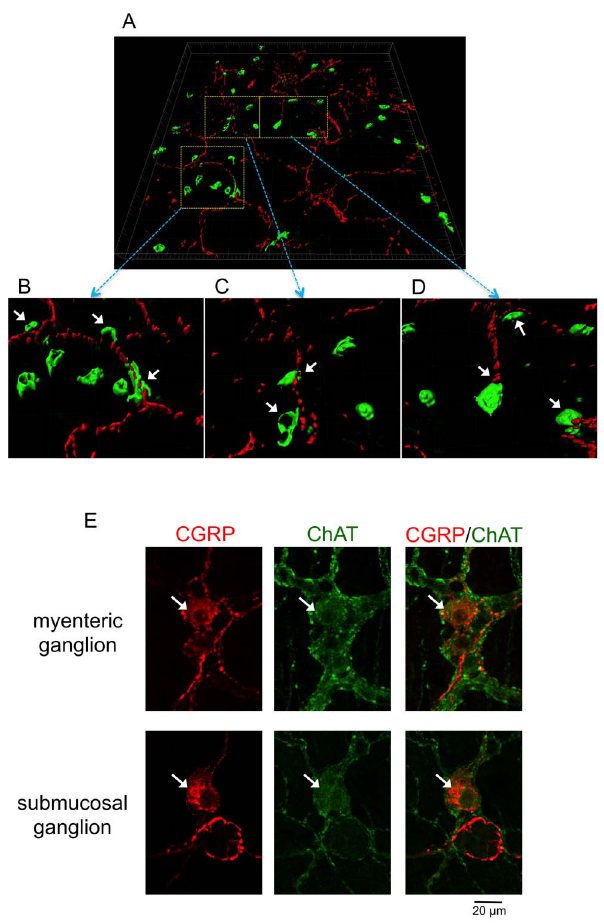
Figure 10. Spatial relationship of mucosal mast cells and cholinergic nerve fibers in the FA mouse colon. A : Three- dimensional reconstruction of the confocal images reveals the morphological interaction of mMCP-1-positive MMCs (green) and cholinergic CGRP- immunoreactive nerve fibers (red). Major grid space represents 20 m m. B – D : High-magnification images of three boxed regions in ( A ). E : CGRP- immunoreactive neurons (arrows) exhibited ChAT immunoreactivities in the myenteric and submucosal ganglion of the mouse enteric nervous system. Scale bar represents 20 m m.